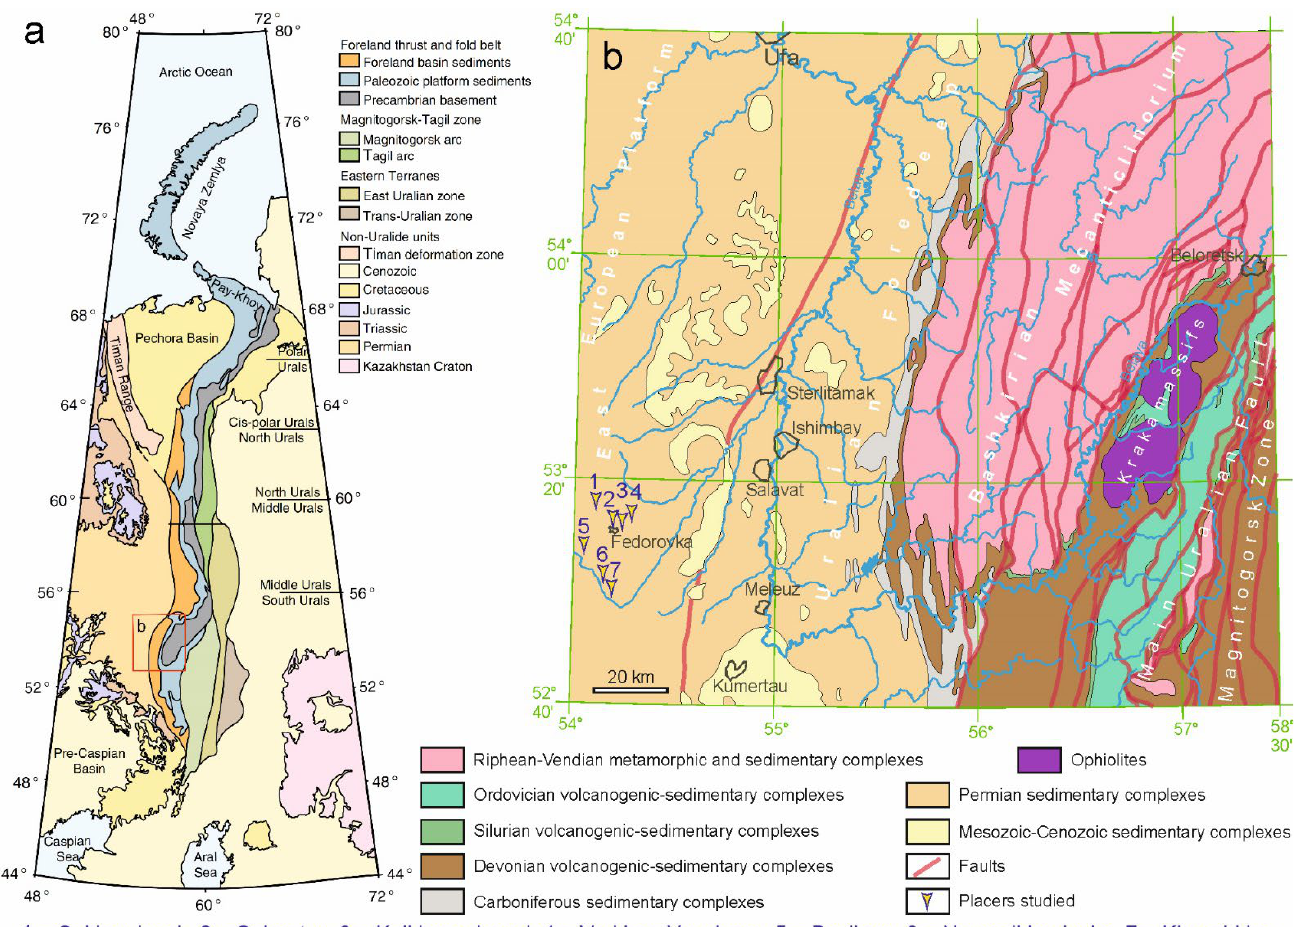
Figure 1. Structural zones of the Uralides [70] ( a ) Corresponding fragment of the State geological map N-40 (Ufa) simplified after Knyazev et al. [75] with the location of the studied chromite placers ( b ).